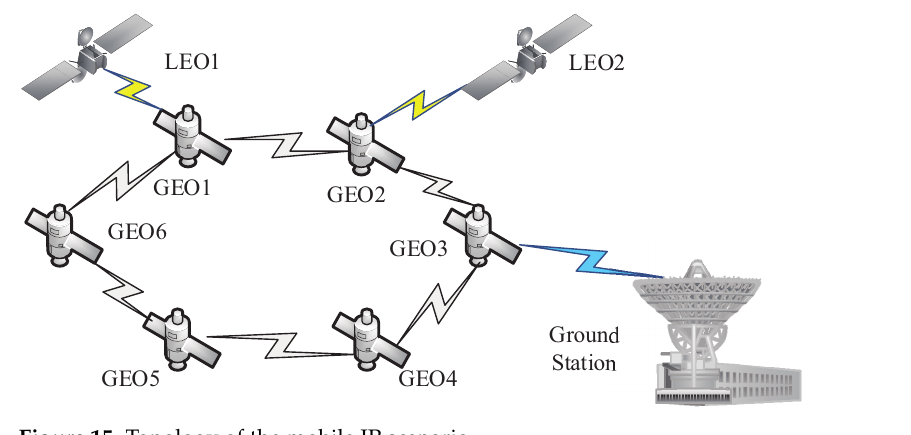
Figure 15. Topology of the mobile IP scenario.